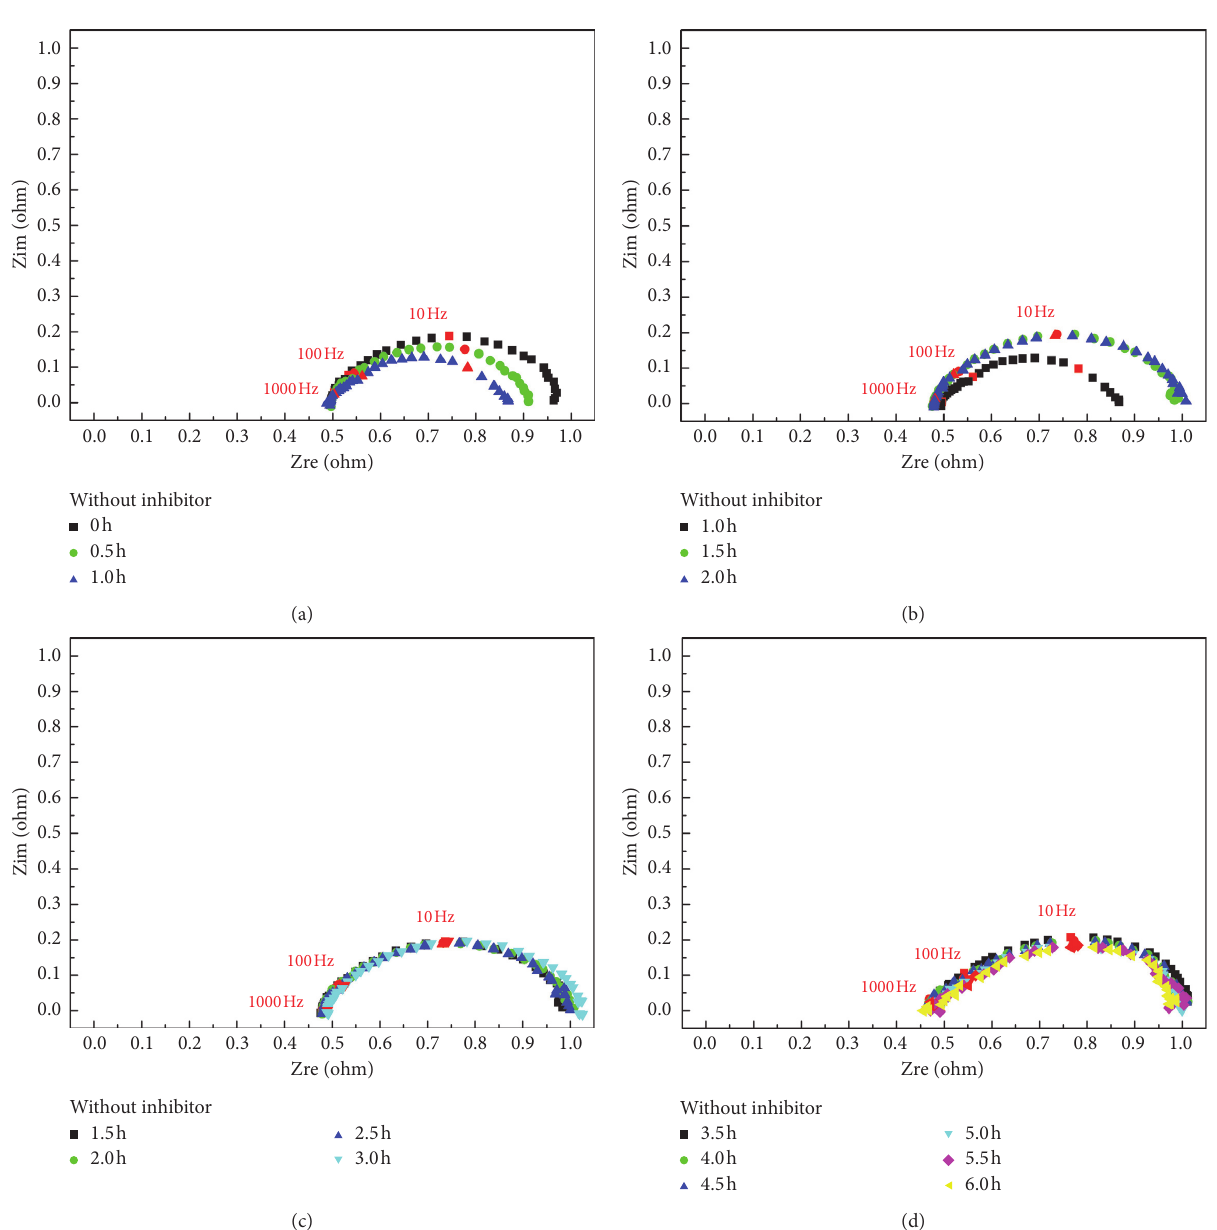
Figure 5: Nyquist diagrams at different times without adding corrosion inhibitor: (a) 0–1.0h. (b) 1.0 h–2.0h. (c) 1.5h–3.0h. (d)